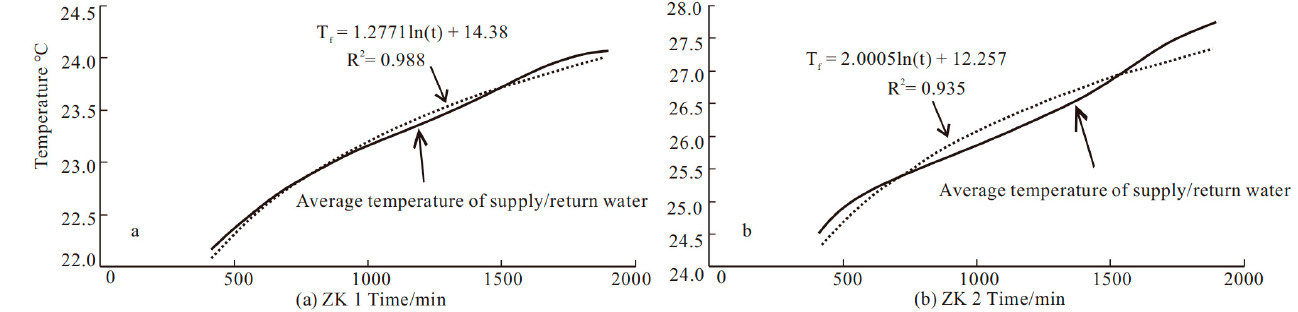
Figure 3. Fluid temperature and time logarithm ZK1 ( a ) and ZK2 ( b